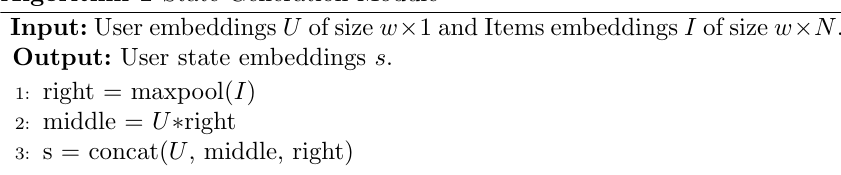
Algorithm 1 State Generation Module